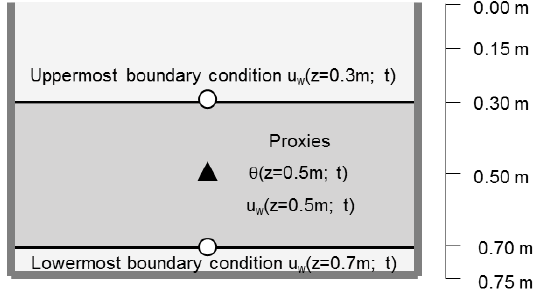
Figure 5. Soil domain investigated for calibration and validation of the soil parameters.